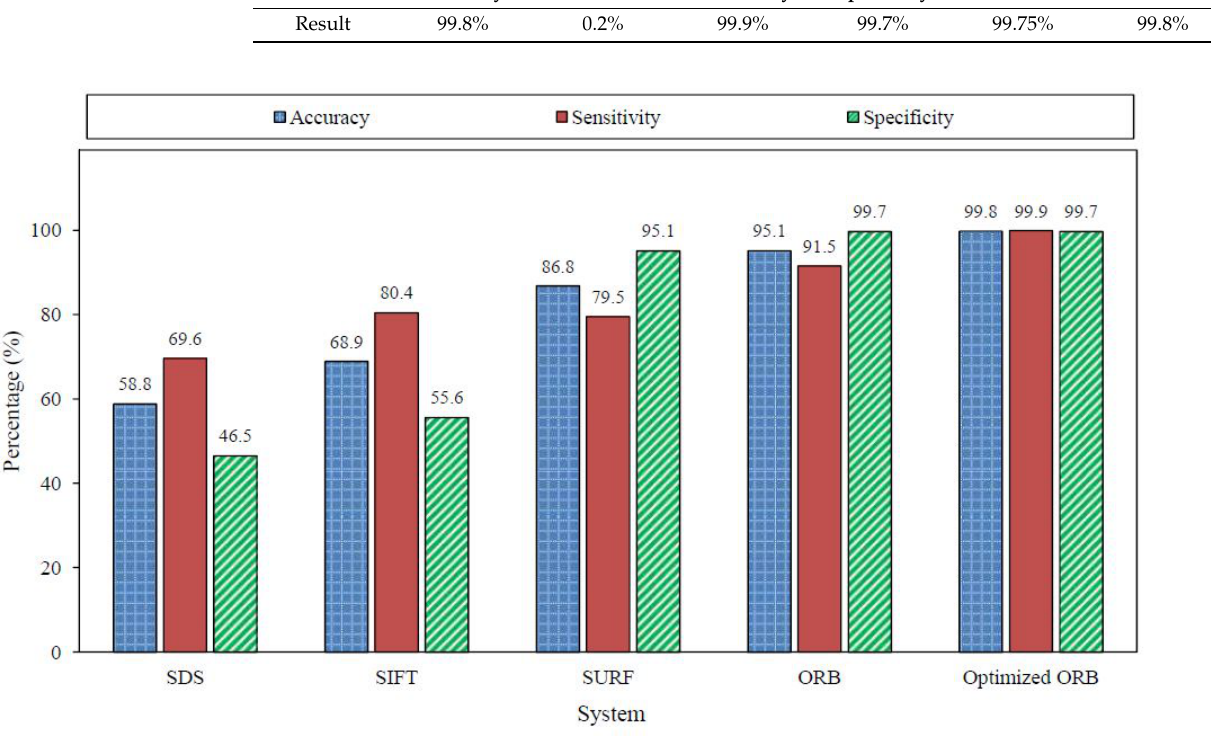
Figure 22. Results summary for the evaluated systems over the 1500